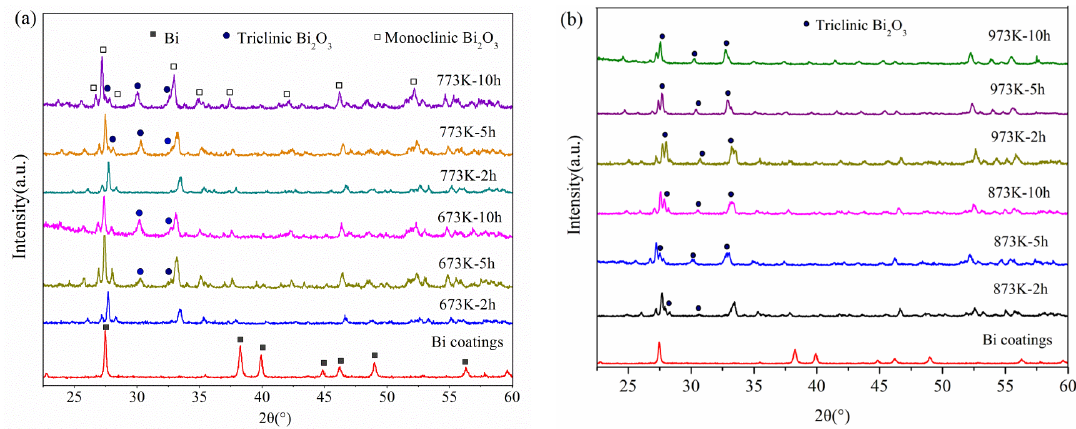
Figure 1. XRD patterns of the as ‐ prepared coatings: ( a ) BC ‐ 673 ‐ 2, BC ‐ 673 ‐ 5, BC ‐ 673 ‐ 10, BC ‐ 773 ‐ 2, BC ‐ 773 ‐ 5, BC ‐ 773 ‐ 10; ( b ) BC ‐ 873 ‐ 2, BC ‐ 873 ‐ 5, BC ‐ 873 ‐ 10, BC ‐ 973 ‐ 2, BC ‐ 973 ‐ 5, BC ‐ 973 ‐